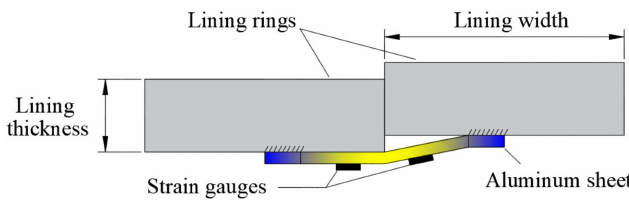
Figure 7. Schematic diagram of the dislocation measuring